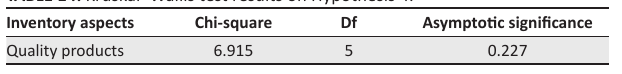
TABLE 14: Kruskal–Wallis test results on Hypothesis